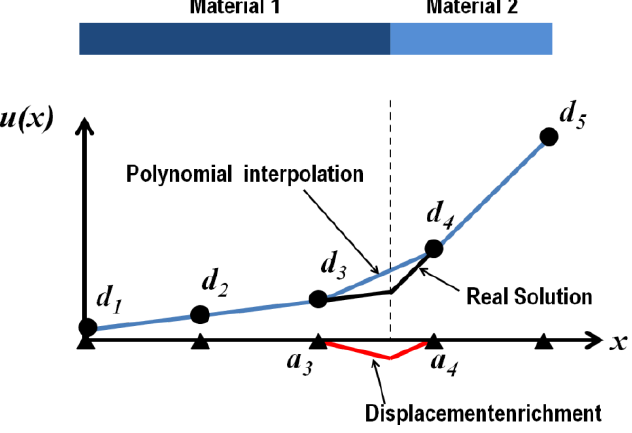
Figure 6. Principle of eXtended Finite Element enrichment by a level set function for a bi-material 1D example. The polynomial variation described by nodal displacements (blue curve with related d unknowns) is complemented by a nodal-based enrichment with limited support (red curve with a unknowns) to obtain the real displacement field without placing nodes at the material